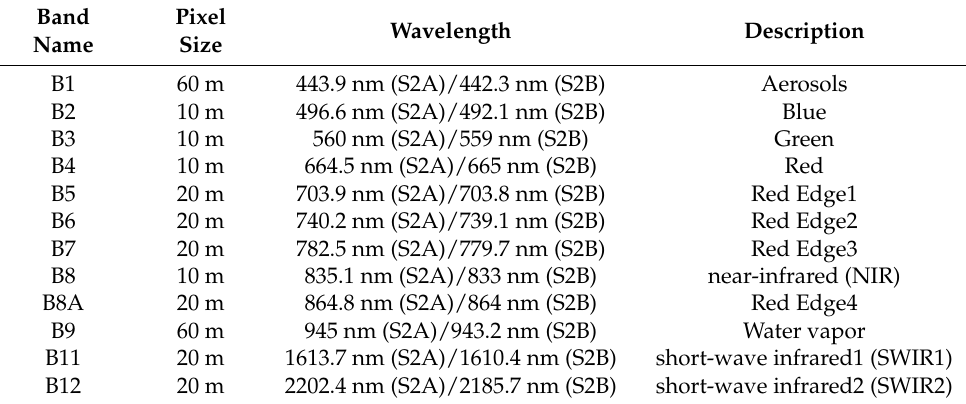
Table 1. The information of the Level-2A product of Sentinel-2.